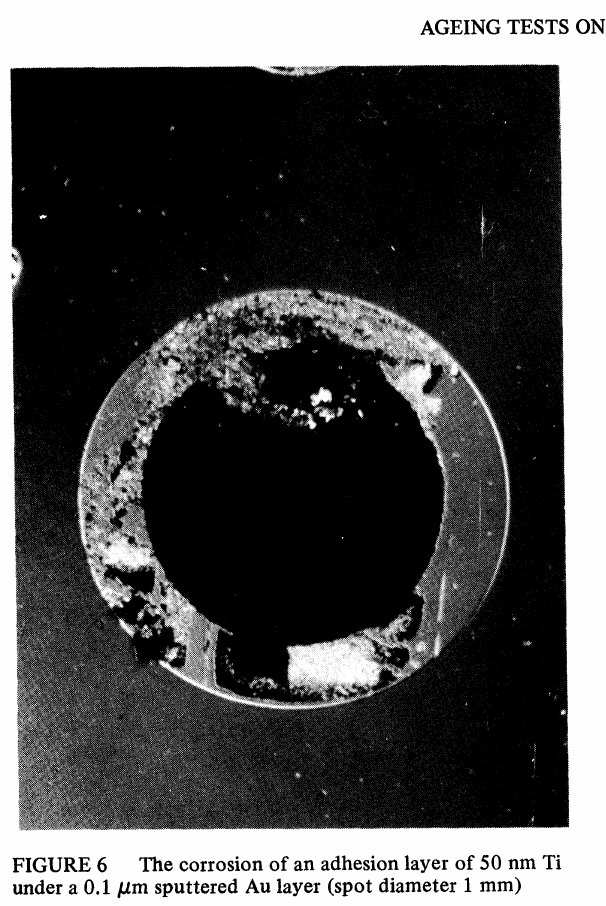
FIGURE 6 The corrosion of an adhesion layer of 50 nm Ti under a 0.1/,tm sputtered Au layer (spot diameter